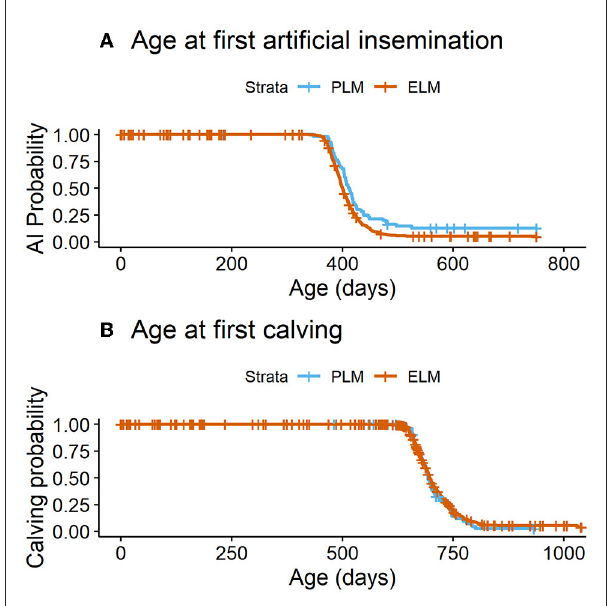
FIGURE4 (A) Time to the occurrence of the first AI by maternal plasma NEFA category in the last 2 weeks of gestation. PLM (physiological lipid mobilization = 529; plasma NEFA < 0.3mM; blue line), ELM (excessive lipid mobilization = 50; plasma NEFA ≥ 0.3mM; red line), P = 0.007. (B) Time to first calving by maternal plasma NEFA category in the last 2 weeks of gestation. PLM (physiological lipid mobilization = 457; plasma NEFA < 0.3mM; blue line), ELM (excessive lipid mobilization = 45; plasma NEFA ≥ 0.3mM; red line), P = 0.4.